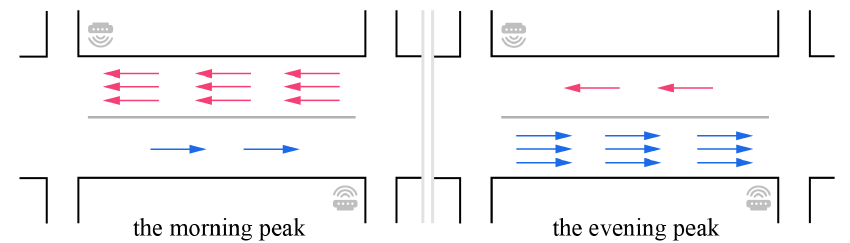
Figure 1. Different traffic conditions of lanes in morning and evening